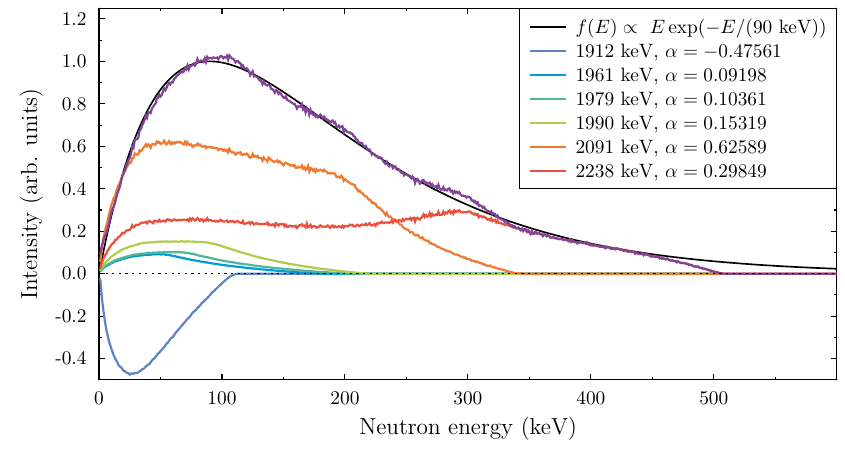
Figure 1. Simulated neutron energy distributions for the synthesis of an energy distribution with k B T =